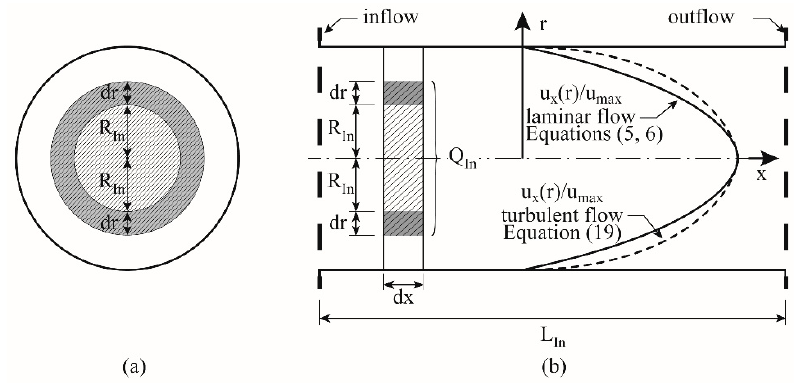
Figure 2. Flow in the inflow area ( a ) cross-sectional view, and ( b ) longitudinal cross-section view. In the considered case, the largest velocity occurs in the centre of the pipe’s cross-section.